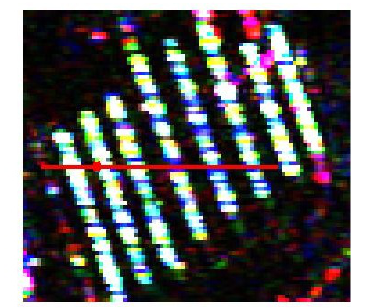
Figure 2. Pattern selected from TerraSAR-X data